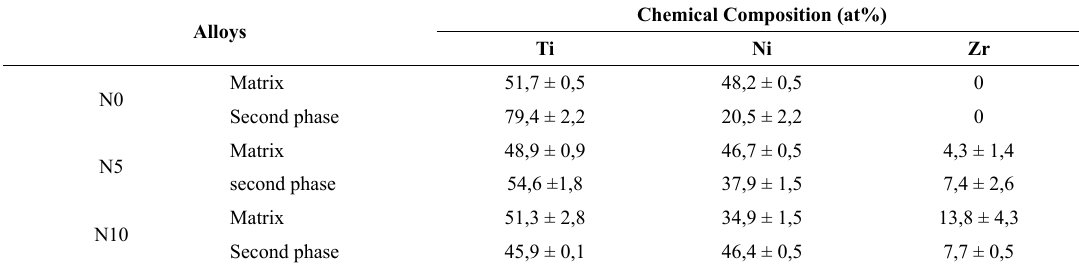
Figure 3. Scanning electron microscopy of the alloys N0 (a-b), N5 (c-d) and N10 (e), respectively. Legend: M: matrix, P: precipitate, S1: second Table 3. Chemical composition of the phases obtained by EDS.